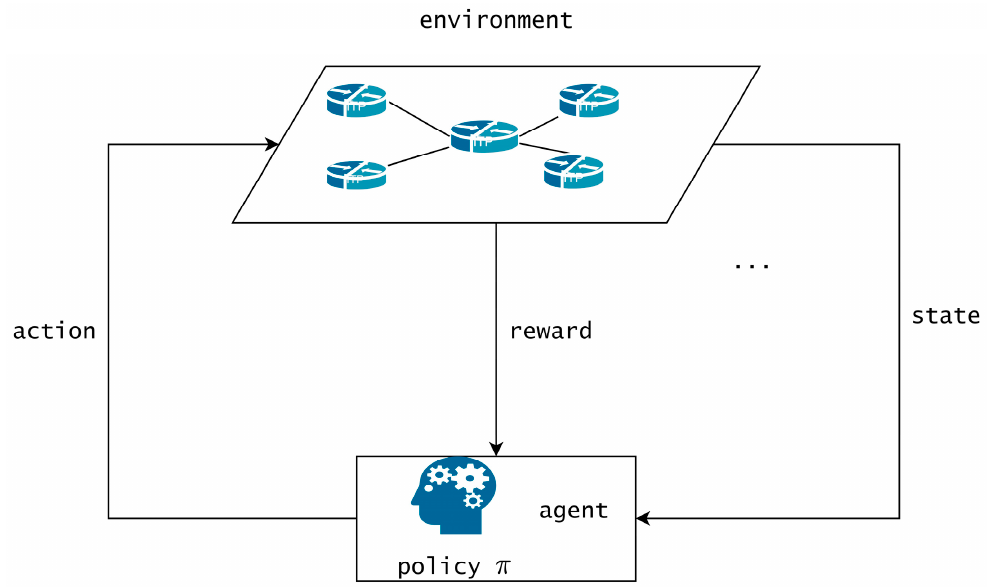
Figure 2. Reinforcement Learning.